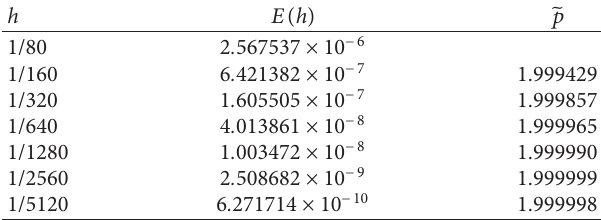
Table 2: The maximum global errors E ( h ) and the observing orders 􏽥 p produced by AB2 when applied to equation (82).